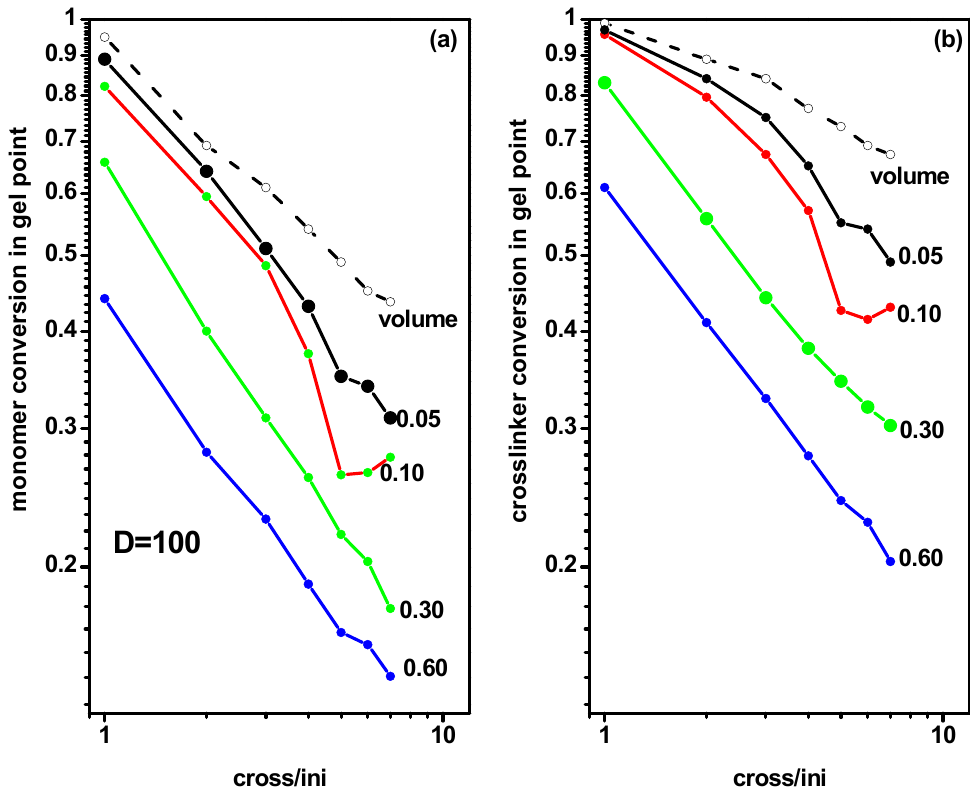
Figure 9. The conversion of monomer ( a ) and cross-linker ( b ) at the gel point for polymerization of grafted chains in a slit with d = 100 as a function of the ratio [Ini]/[X] for different widths of the slit. The grafting densities are given in the inset. The monomer and cross-linker conversion at gel point for a free volume are marked by the dashed line.